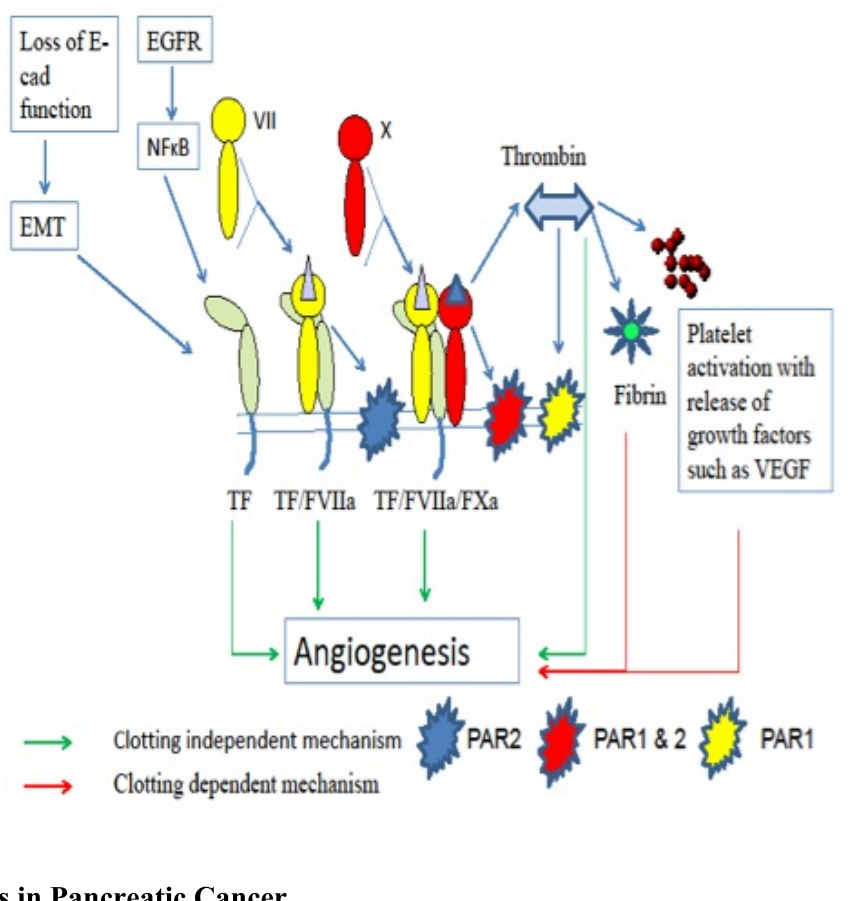
Figure 2. Clotting dependent and independent mechanisms of